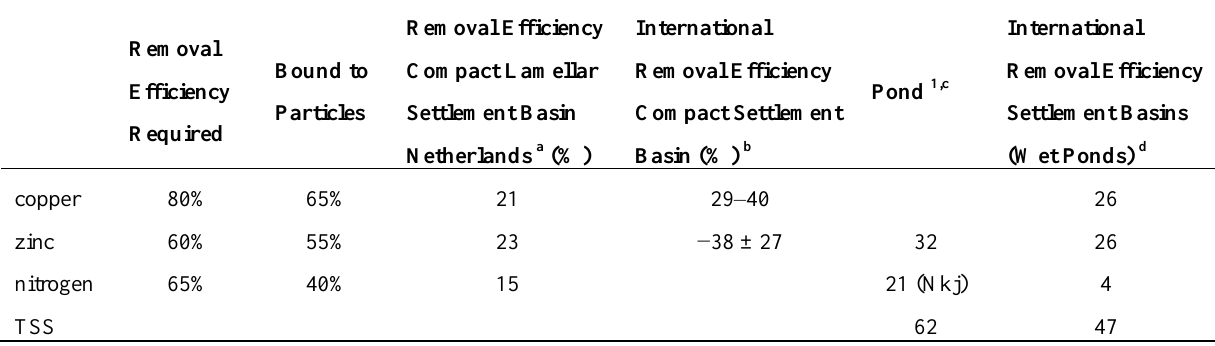
Table 4. Comparing required removal efficiency and basic pollutant behaviour.